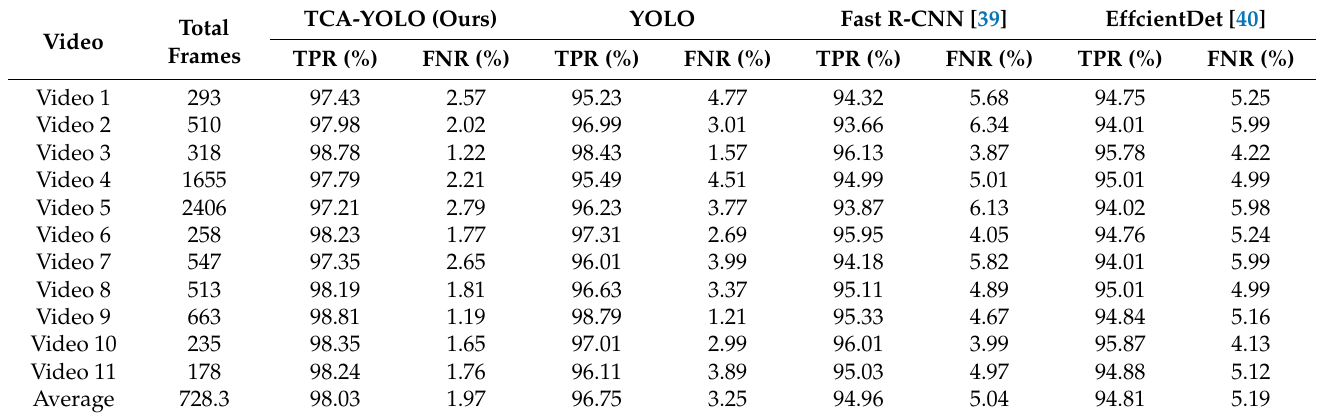
Table 3. Performance when detecting open forest fire video dataset